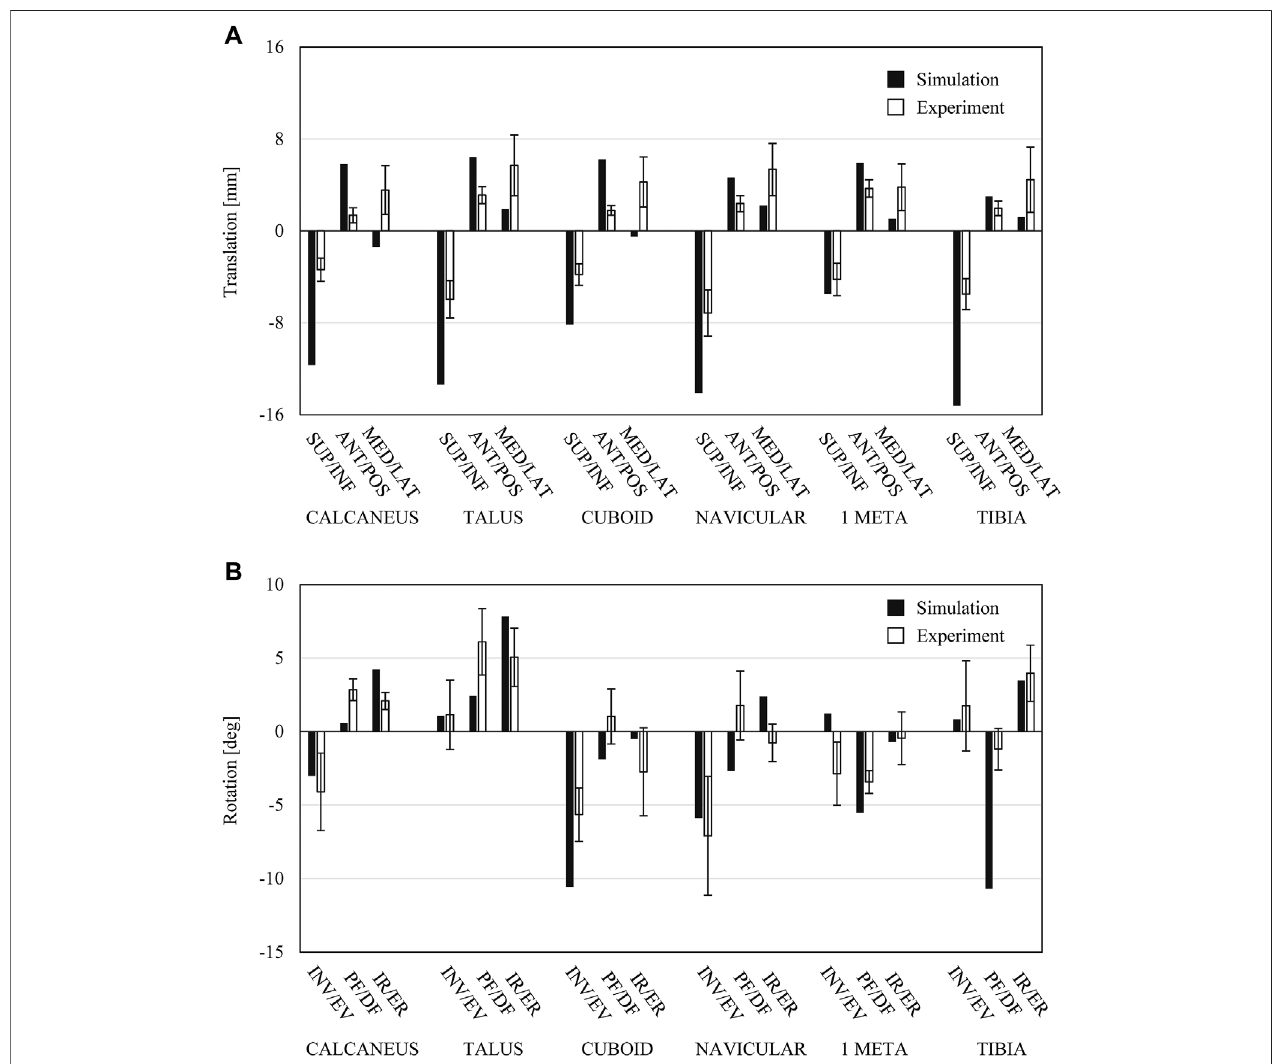
FIGURE 2 | Comparisons between simulated bone movements in human foot model during axial loading and experimentally measured foot bone movements during axial loading (Negishi et al., 2021). (A) Translational displacements of foot bones in superoinferior, anteroposterior and mediolateral directions. (B) Rotational displacements of foot bones in coronal sagittal and transverse